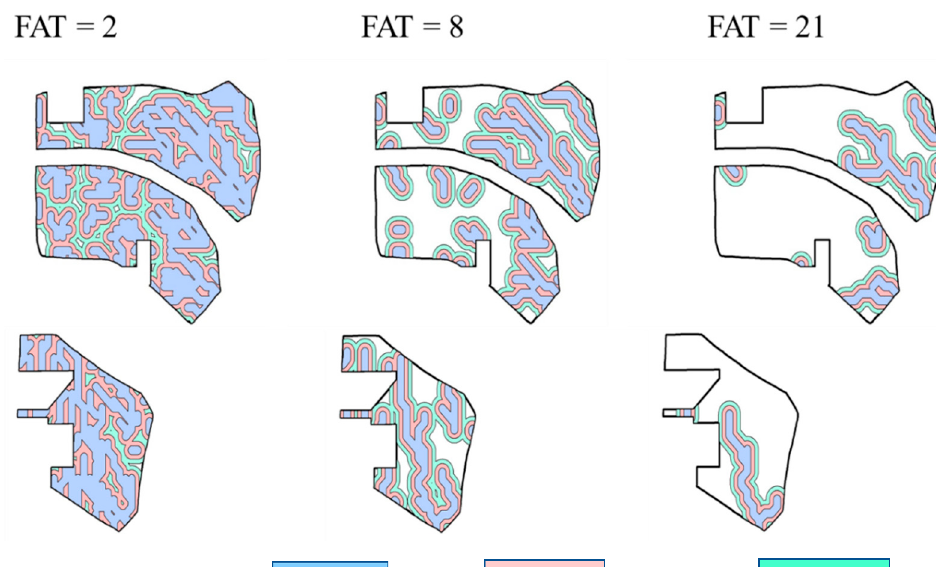
Figure 5. Buffer zones 0–5 m , 5–10 m , and 10–15 m around the potential subsurface flow pathways derived with three flow accumulation threshold (FAT) values at fields A, B, and D.